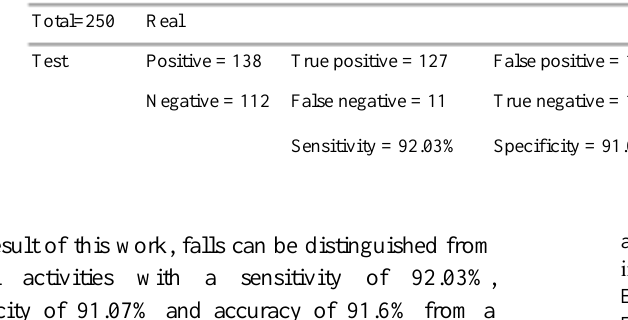
Table 4. Fall detection statistical